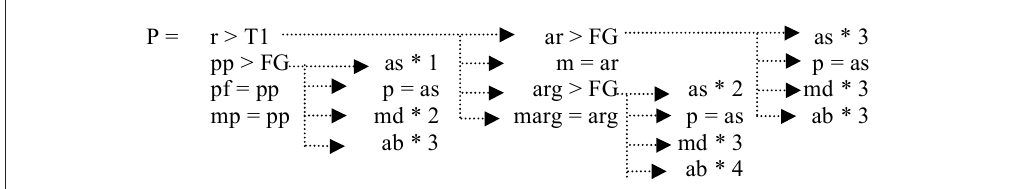
Figura 3. Representação esquemática da árvore de decisão utilizada na avaliação do milho, considerando o requerimento de uso da terra condições de enraizamento. Em que: P - profundidade do solo; T1 - textura superficial; FG - fragmentos grosseiros; r - raso; pp - pouco profundo; pf - profundo; mp - muito profundo; ar - arenosa; m - média; arg - argilosa; marg - muito argilosa; as - ausente; p - pouco; md - moderado; ab - abundante; *1 - limitação nula ou ligeira; *2 - limitação moderada; *3 - limitação forte; *4 - limitação muito